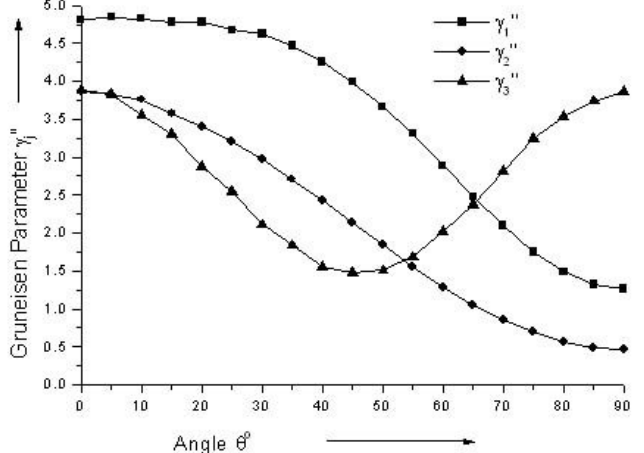
g ¢¢ with angle q for the different acoustic j